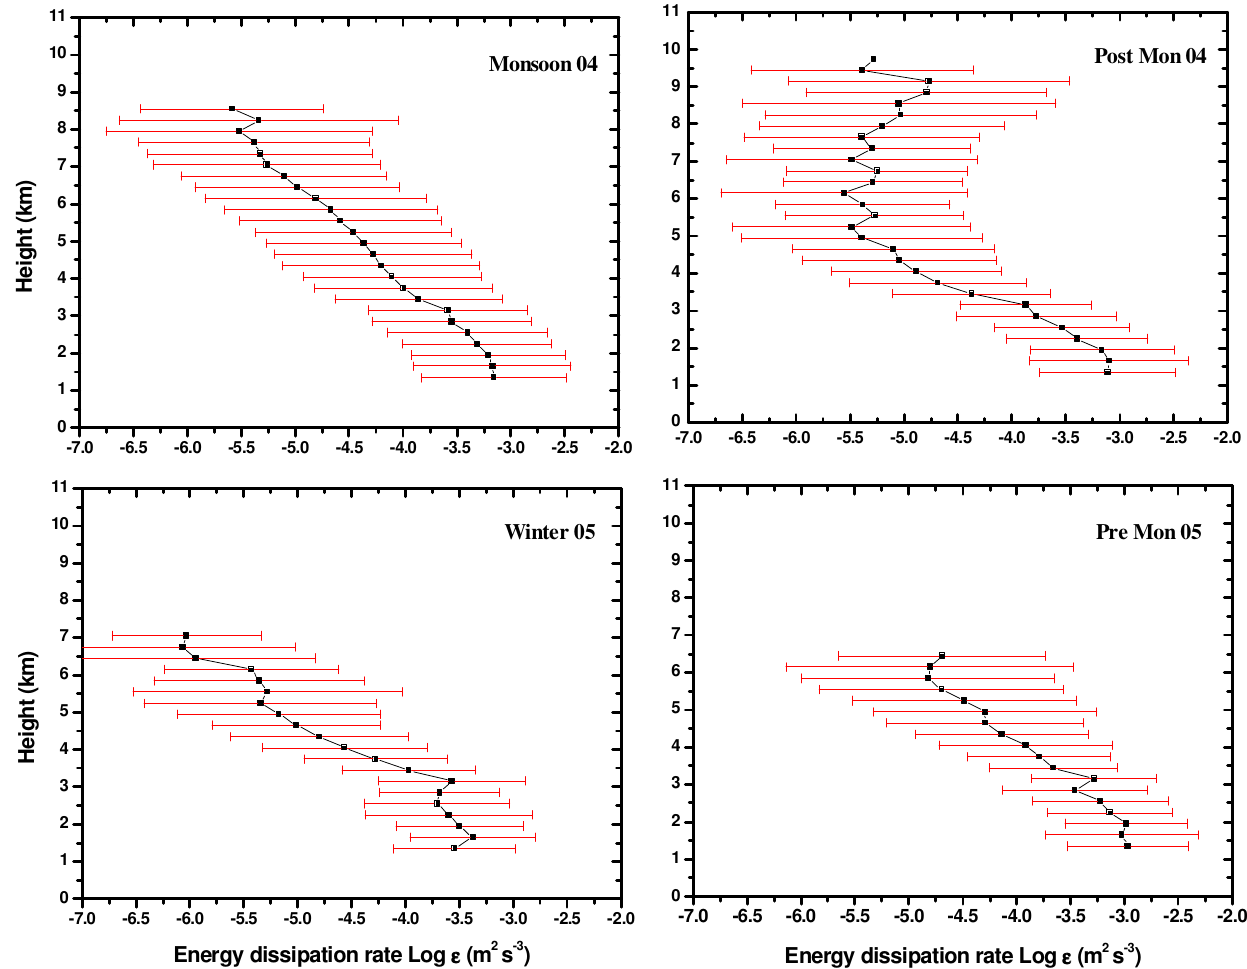
Fig. 12. Energy dissipation rates with standard deviation, 2004–2005. Total number of available data points for calculating seasonal mean and standard deviation of ε are, 82 (for monsoon 2004, the upper left panel), 66 (for post-monsoon 2004, upper right panel), 53 (for winter 2005, bottom left panel), and 87 (for pre-monsoon 2005, bottom right